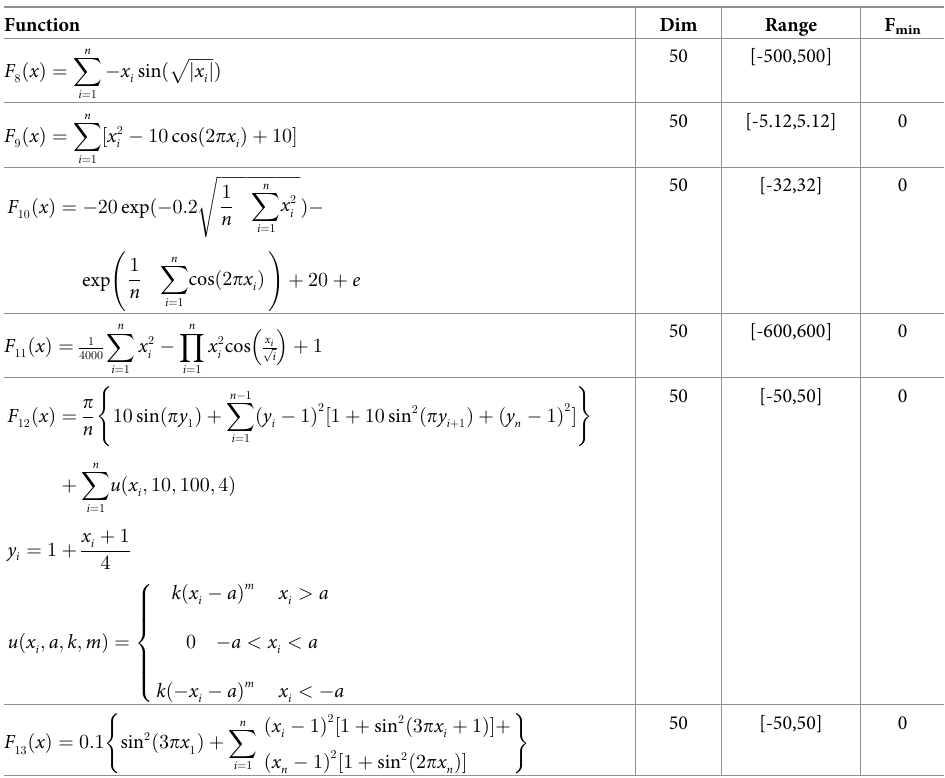
Table 2. Multi-modal benchmark functions. Function Dim